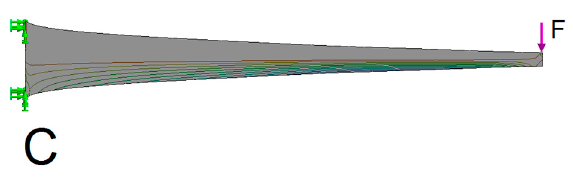
Figure 10. Direction of the principal compressive stresses of a parabolically formed beam (beam C) with distributed stress.